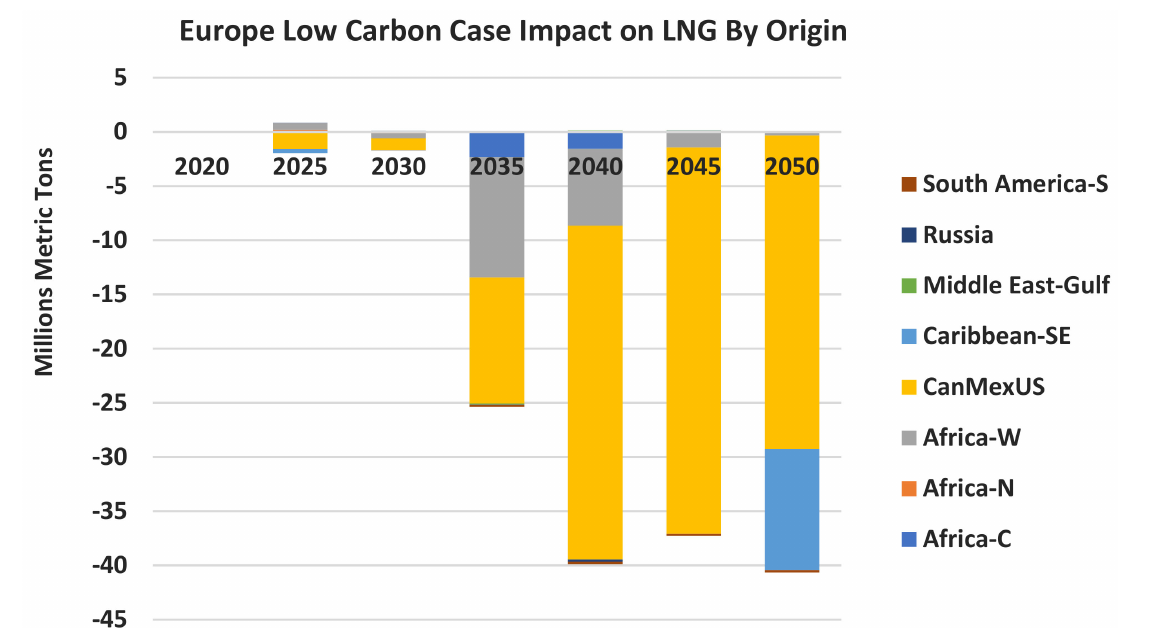
Figure 25. Europe LNG impact by origin in low-carbon case compared to base. Besides Europe, we go further into the LNG trade differences across each major LNG region. So, moving from Europe to the East, the Southeast and Southwest Asia region has small impacts in terms of total LNG imports as in Figure 26. Due to the changes in Europe here in the base case, the main LNG suppliers are the Middle East and Australia, and then later Africa SE (Mozambique and Tanzania), while in the low-carbon europe case, the Middle East and Australian imports are replaced by LNG from the Russia/European route and North America for a total of about 36 million tons, which is 80% of what is lost in the European market, shown in Figure 27.